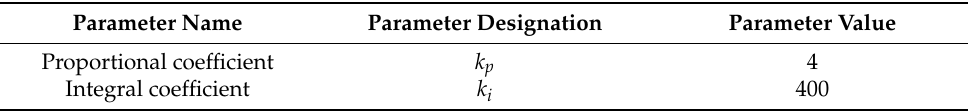
Table 3. Parameters of PI controller of projections of electric motor current on the d and q